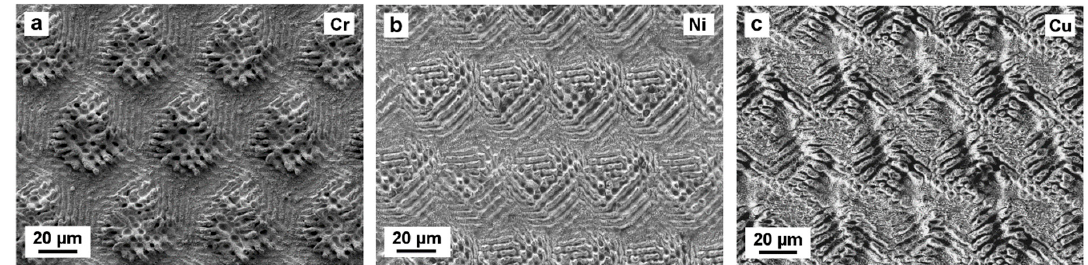
Figure 3. SEM images of ( a ) Cr, ( b ) Ni, and ( c ) Cu structured by four-beam DLIP with a fluence of 15.4 J/cm 2 and 80 pulses.